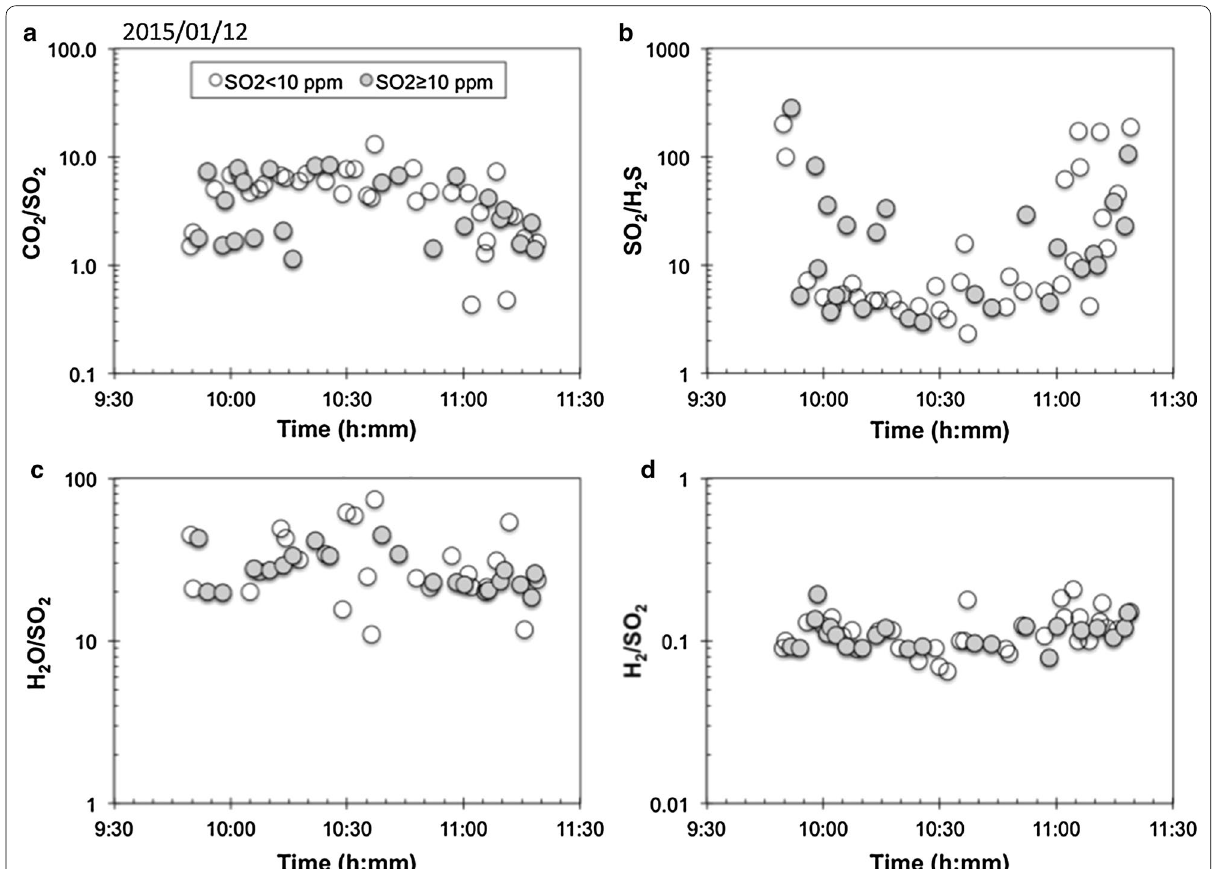
Fig. 4 A short-term variation of gas concentration molar ratios on 12 January 2015. a CO 2 /SO 2 molar ratio, b H 2 O/SO 2 molar ratio, c SO 2 /H 2 S molar ratio, and d H 2 /SO 2 molar ratio. Grey circles show ratios obtained for high concentration peaks of SO 2 concentration peaks of